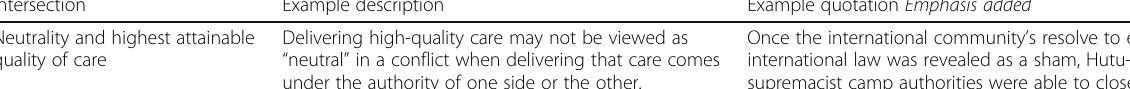
Table 4 Examples that illustrate the potential intersection between humanitarian principles and ethical obligations